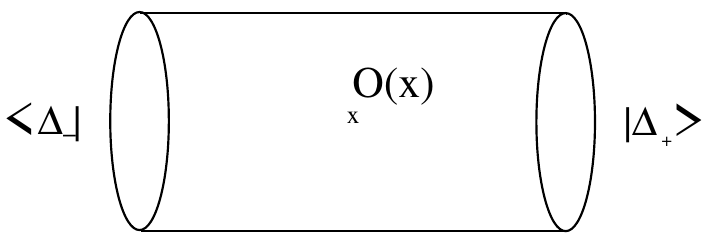
Figure 1 . The pictorial representation of the cylindrical geometry for the small volume